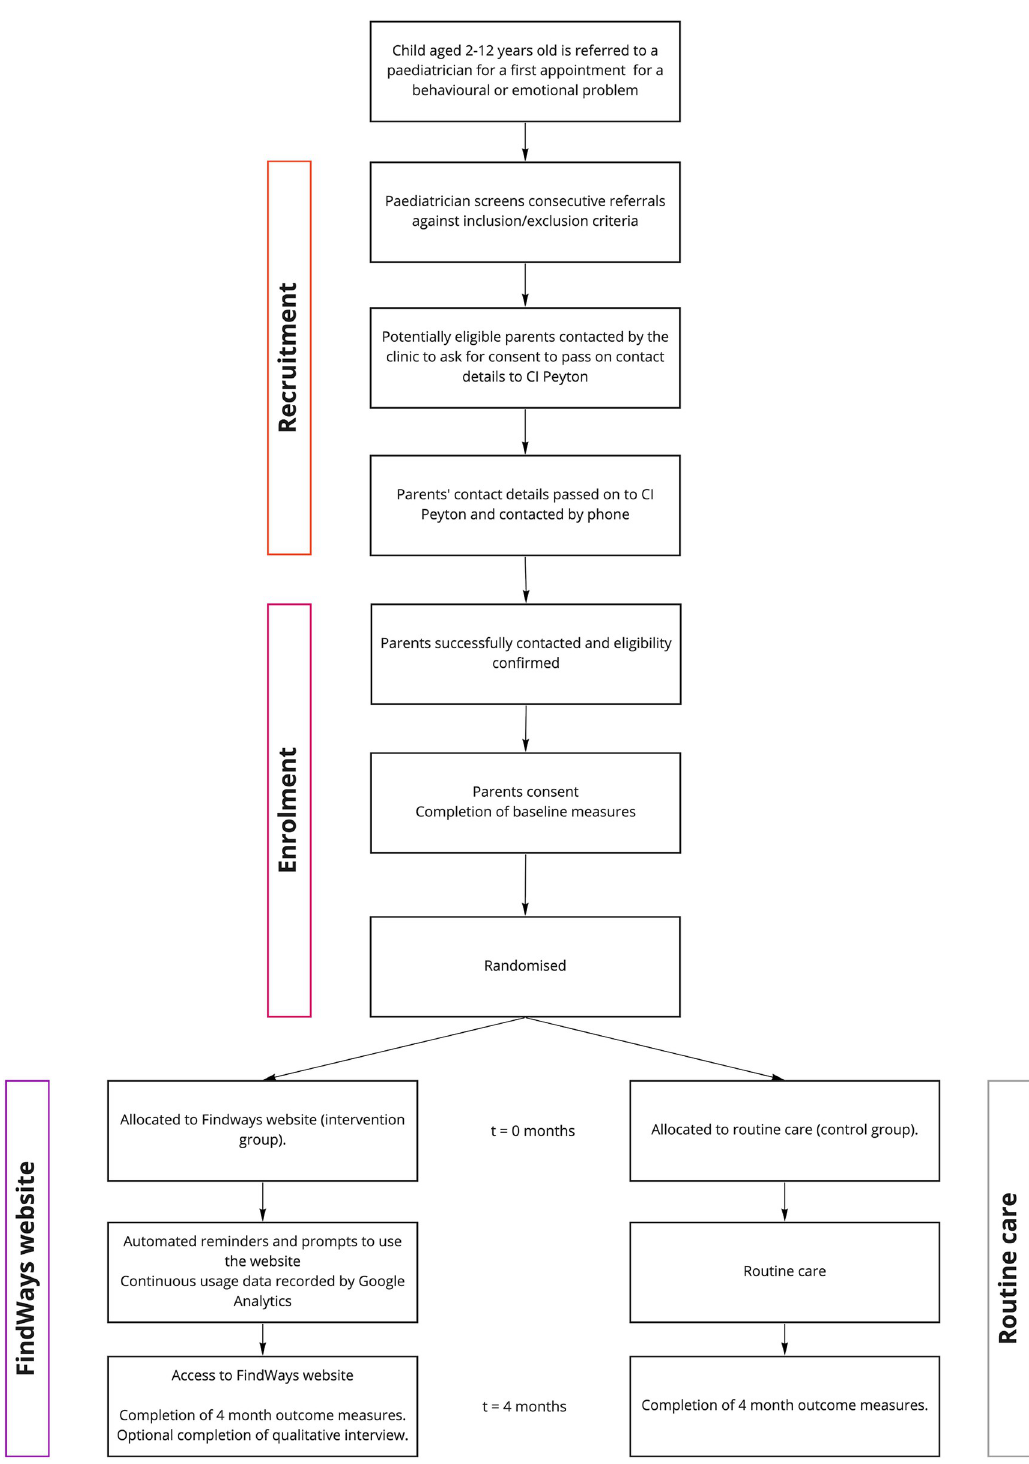
Fig 2. CONSORT flow diagram. Study design flowchart of the FindWays trial.